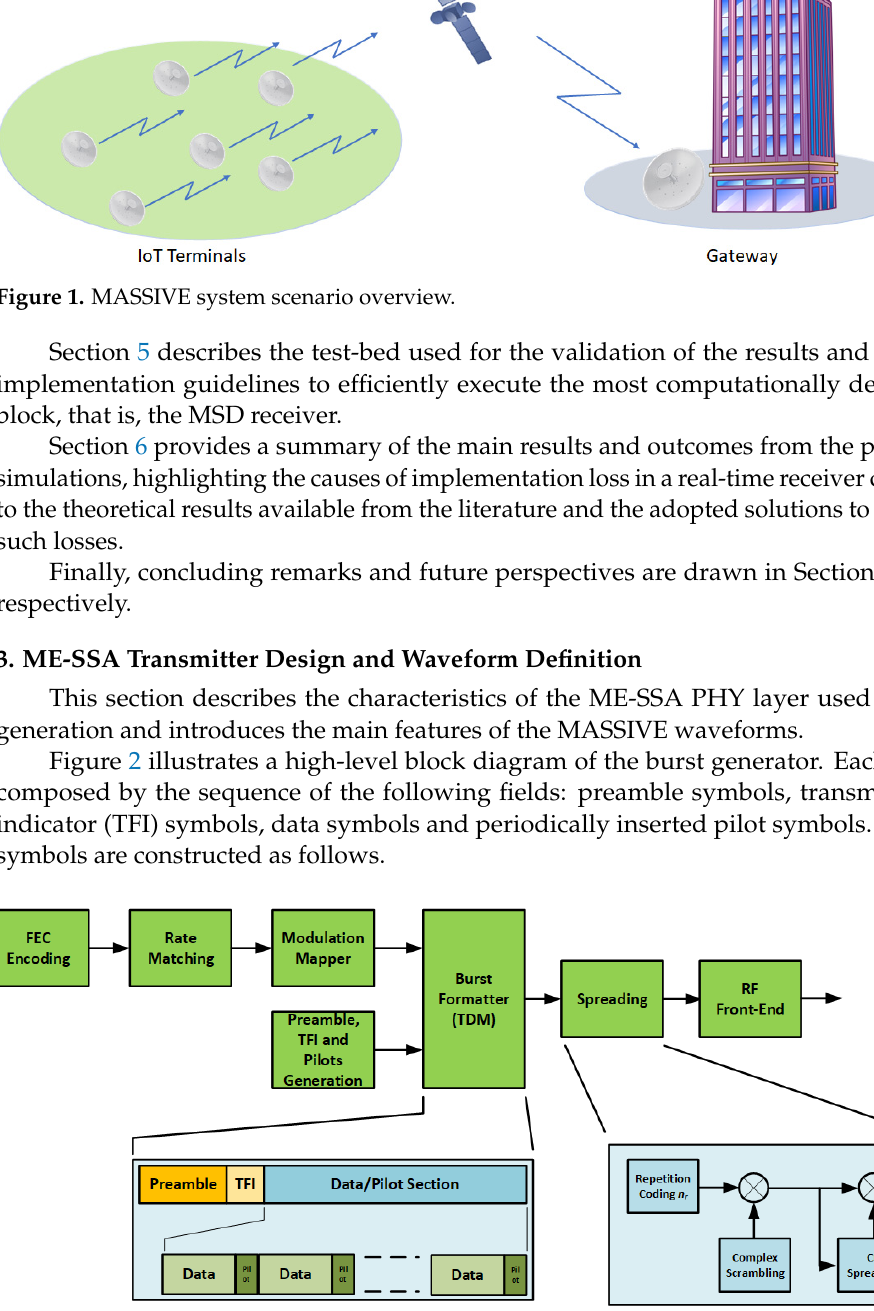
Figure 2. MASSIVE burst generator